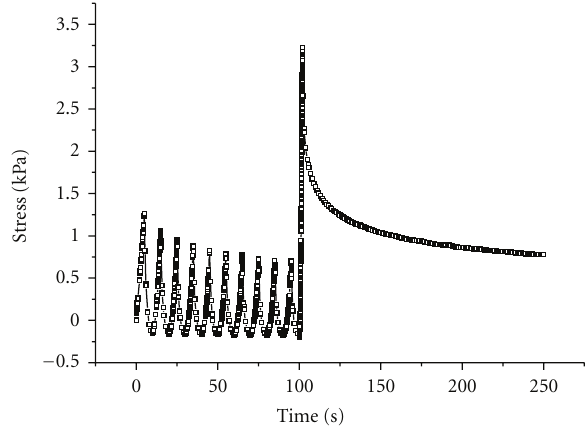
Figure 4: Tensile linear modulus of ring-shaped collagen gels as a function of temperature (experiments performed either at 23 ◦ C or 37 ◦ C), hydration (either with or without a PBS solution), and mechanical preconditioning (either with or without mechanical preconditioning PC). Values are expressed as mean ± standard error. Significance: ∗ P < 0 . 05; ∗∗ P < 0 . 01; ∗∗∗ P < 0 .